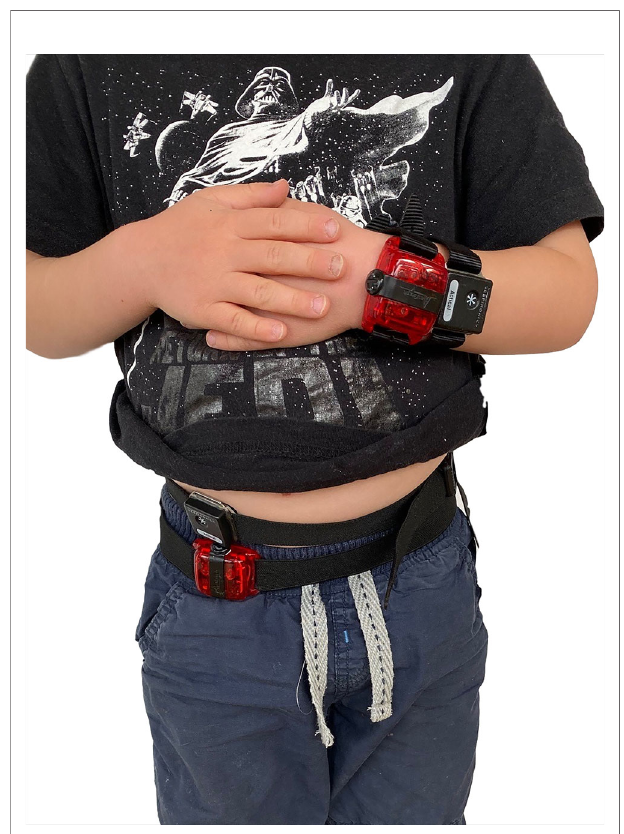
FIGURE 1 | Site placements for wrist and waist worn ActiGraph GT3X+ and Actical